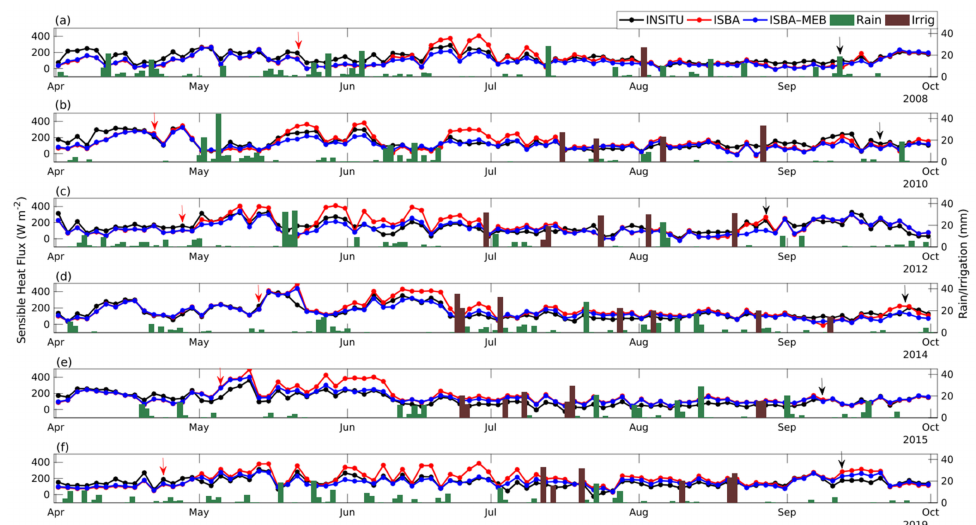
Figure 6. The 2-days average daytime series of the in situ sensible heat flux (H) (in black) with those estimated by ISBA (in red) and ISBA-MEB (in blue). Panels ( a – f ) represent the plots for 2008, 2010, 2012, 2014, 2015, and 2019, respectively. The red and black arrows signify the planting and the harvest days, respectively.